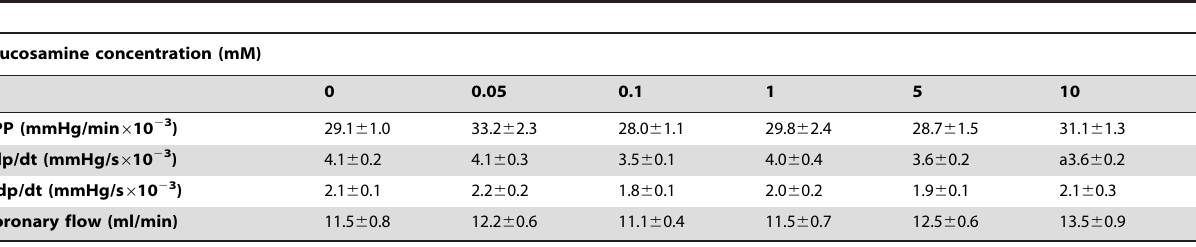
Table 1. Cardiac function of isolated rat hearts perfused with 0 (n=8), 0.05 (n=5), 0.1 (n= 10), 1 (n=4), 5 (n=8) and 10 mM (n= 7) glucosamine for 60 minutes (hearts were paced at 320 beats/min